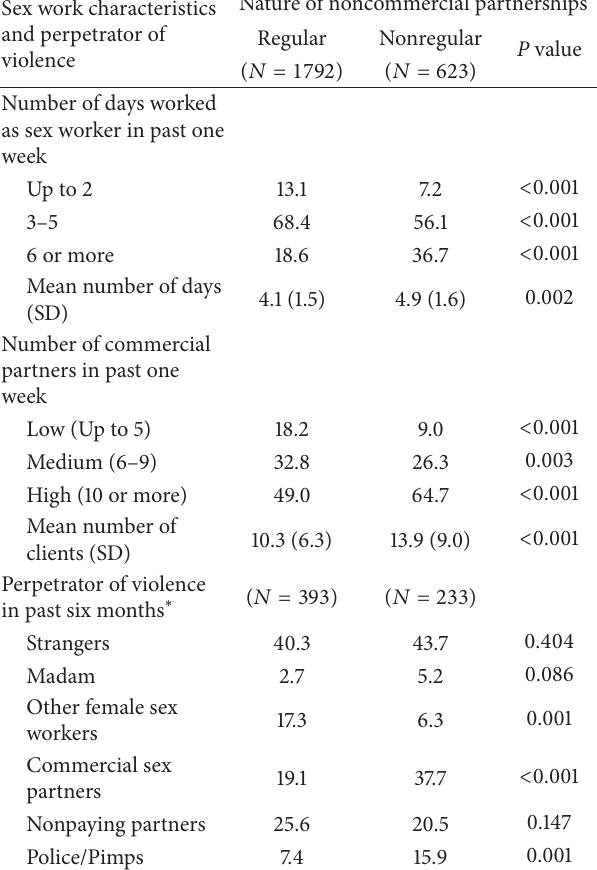
Table 4: Sex work characteristics and perpetrator of violence by nature of noncommercial partnerships among female sex workers, Andhra Pradesh,